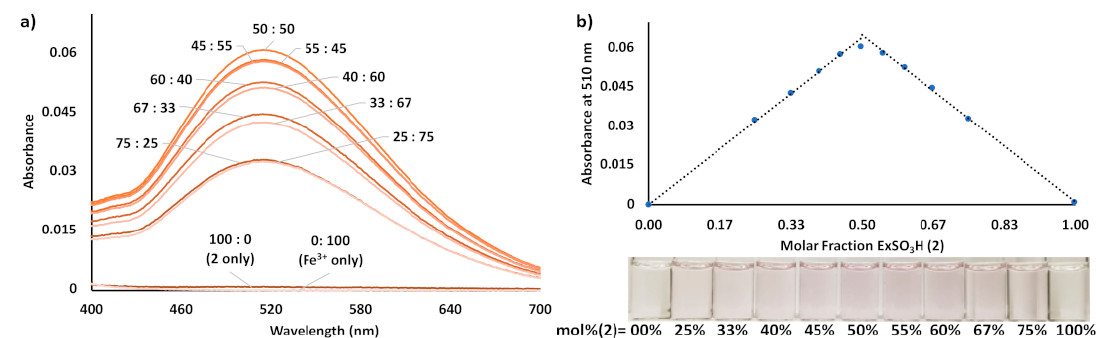
Figure 2. ( a ) Absorbance profiles of varying ratios of 2 and Fe 3+ (as FeCl 3 ) indicated as mol% 2 : Fe 3+ in 0.1 M aqueous acetate buffer at pH = 3 with the sum of both species = 50 µ M at each datum point. ( b ) Corresponding Job’s plot of the absorbance at 510 nm of 2 and Fe 3+ . A maximum in the absorbance intensity is seen at a mole fraction = 0.5, a finding consistent with a 1:1 binding ratio.